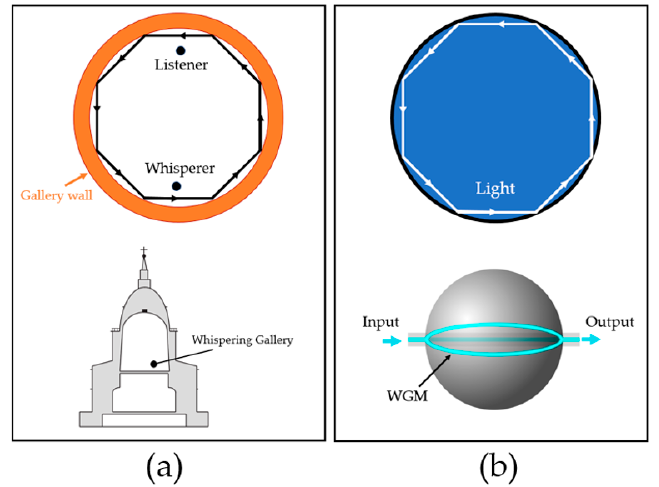
Figure 4. Comparison of mechanical wave and electromagnetic wave WGM. ( a ) Diagram shows how WGM occurs: sound travels from one side of the gallery to another in the structure of St. Paul’s Cathedral where WGM was first observed; ( b ) WGM of light: light is totally internally reflected within the small curved cavity [54,75]. The phenomenon can be observed as light trapped inside the spherical structure